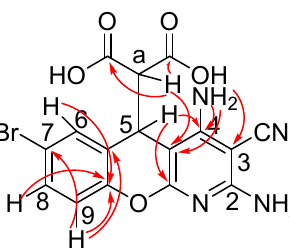
Figure 1. The structure of compound 4f . Key 1 H- 13 C-HMBC spectrum correlations established by NMR are shown by arrows.